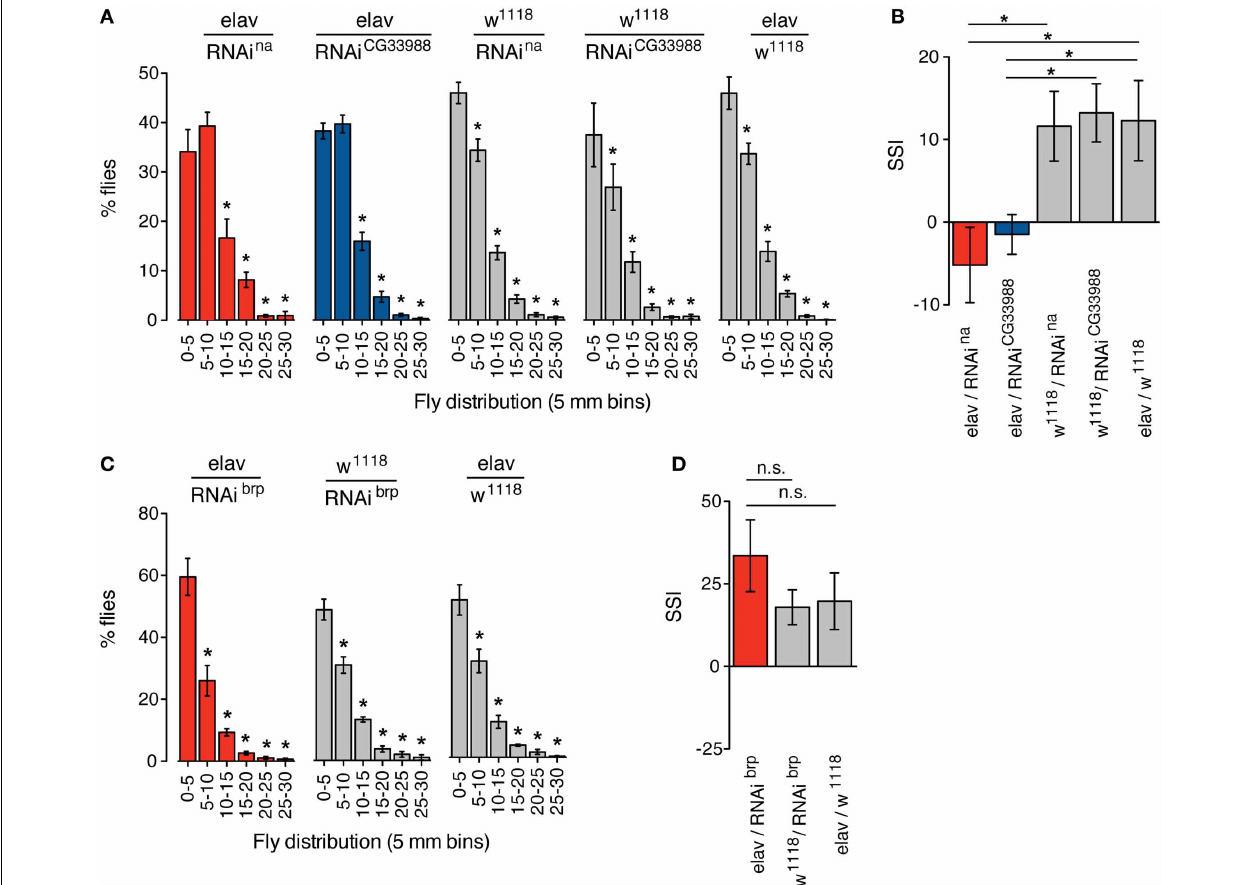
FIGURE 4 | Targeted RNAi knockdown of na or CG33988 expression disrupts social clustering behavior. Quantification of the social space of flies housed in a horizontal circular chamber are shown. (A) The histograms display the frequency distribution of the distance between each fly and its closest neighbor expressed as a percentage of the total population, in 5mm bins, for flies carrying UAS-responsive RNAi against na or CG33988 driven by the pan-neural elav -Gal4 driver, or control flies carrying the elav -Gal4 driver in the w 1118 background, but lacking the UAS-RNAi transgene, or control flies carrying each UAS-RNAi transgene in the w 1118 background, but lacking the elav -Gal4 driver. (B) Social Space